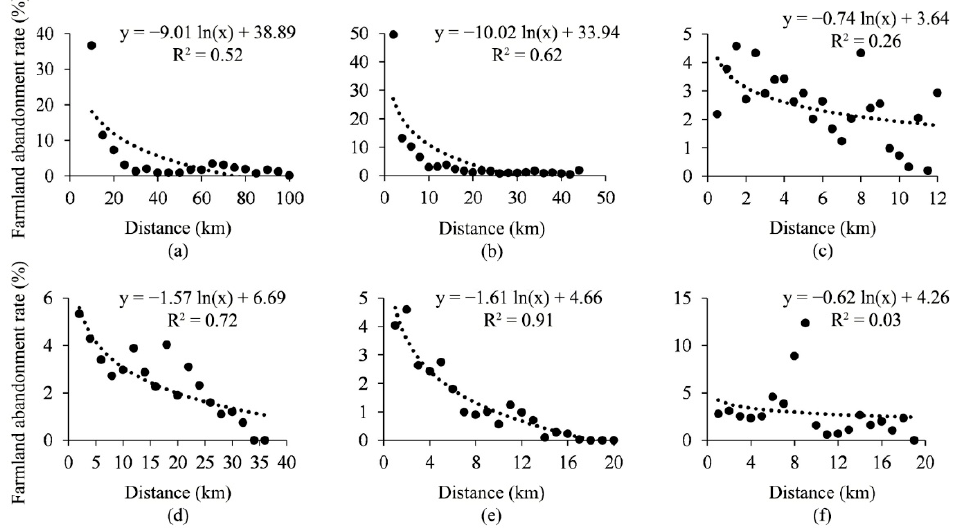
Figure 3. Relationships between farmland abandonment rate and distance to regional centers and roads of different levels. ( a ) The relationship between farmland abandonment rate and distance to the city center; ( b ) The relationship between farmland abandonment rate and distance to the nearest county center; ( c ) The relationship between farmland abandonment rate and distance to the nearest town center; ( d ) The relationship between farmland abandonment rate and distance to national highway; ( e ) The relationship between farmland abandonment rate and distance to provincial highway; ( f ) The relationship between farmland abandonment rate and distance to county highway.